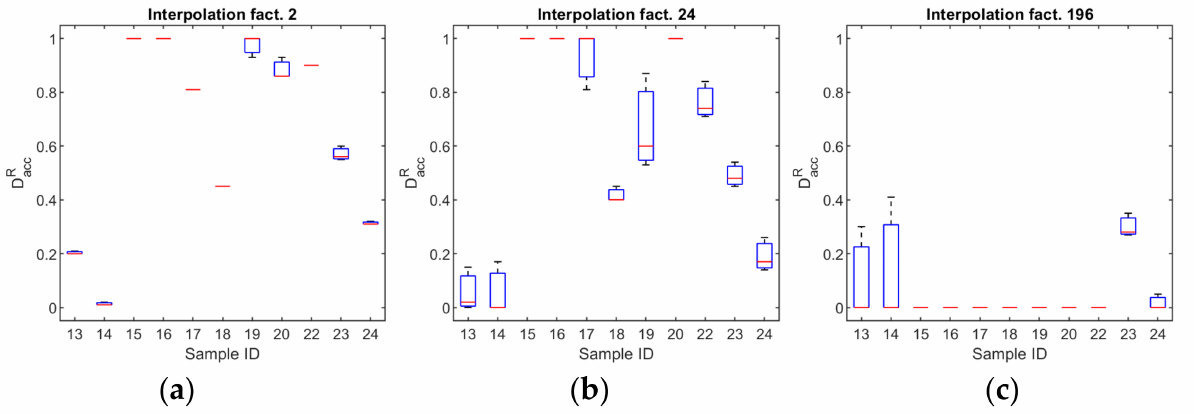
Figure 25. Absolute overall detection accuracy for the incorrect joint regarding the burn-through defect: ( a ) 2, ( b ) 24, ( c )